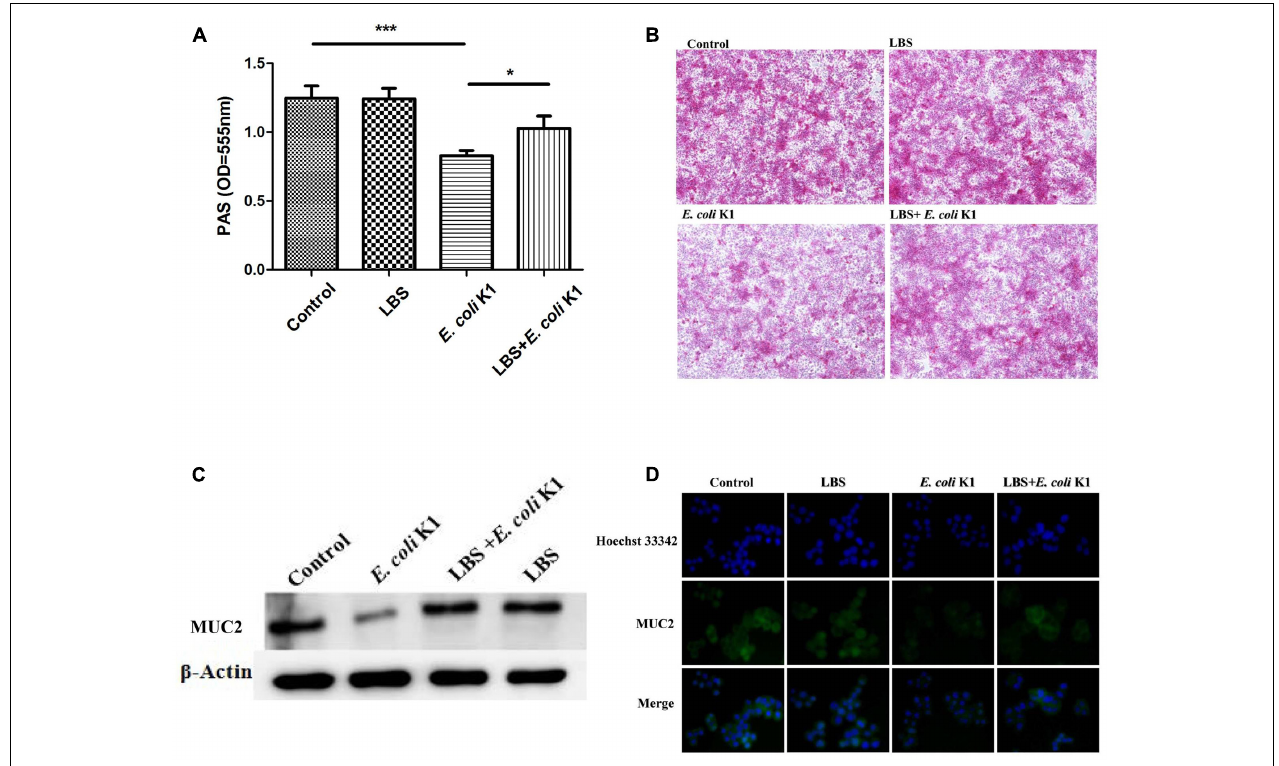
FIGURE 1 | Lactobacillus bulgaricus , Bifidobacterium, and Streptococcus thermophilus (LBS) alleviates mucin degradation during Escherichia coli K1 infection. HT-29 cells were pre-treated with or without LBS before E. coli K1 infection. Cells treated with PBS or LBS alone were served as controls. Cellular proteins were extracted for (A) periodic acid-Schiff (PAS) assay and (C) western blot analysis. (B) HT-29 monolayers were stained with PAS and observed under light microscope (100 × magnification). (D) Immunofluorescence of MUC2 was obtained by fluorescence microscopy (200 × magnification), green staining represents the MUC2, the cell nuclei were stained with Hoechst 33342 (blue). Results are represented as mean ± SD. ∗ P < 0.05, ∗∗∗ P < 0.001.